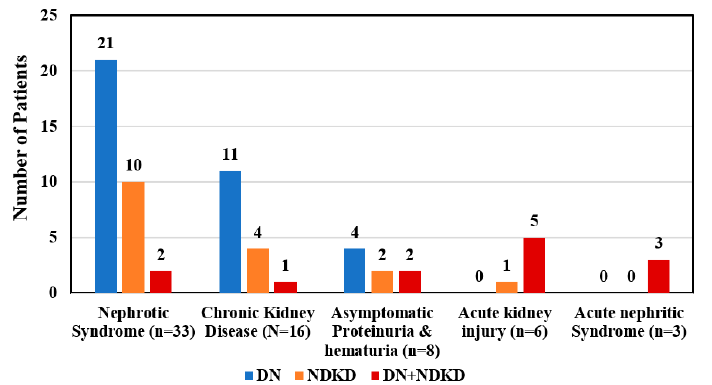
Figure 1. Presenting clinical syndrome in patients with type 2 diabetes mellitus (n = 66). NS: Nephrotic Syndrome, CKD: Chronic kidney Disease, AUA: Asymptomatic Urinary Abnormality, AKI: Acute Kidney Injury, ANS: Acute Nephritic Syndrome.